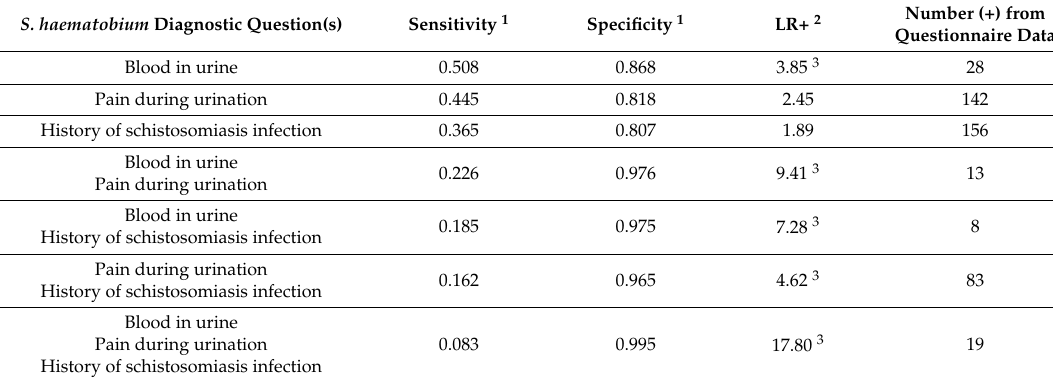
Table 1. Diagnostic performance of each question and combination of questions for correctly classifying an individual as S. haematobium- positive.